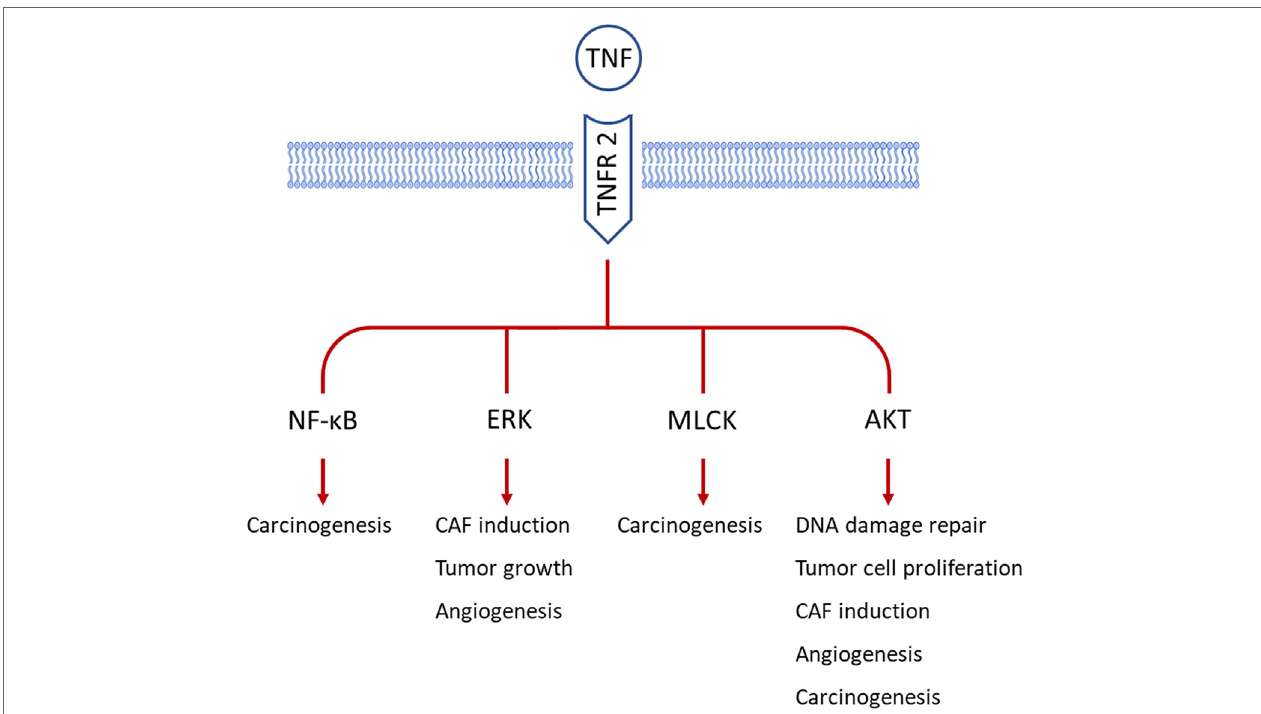
FiGURe 2 | TNF receptor 2 (TNFR2) participates in various processes of tumor development by employing different signal pathways in tumor cells. So far, TNFR2 is reported to be expressed on tumor cells from breast cancer, cervical cancer, colon cancer, and renal cancer. AKT signaling is the major mediator of TNFR2 in carcinogenesis, tumor growth, angiogenesis, and cancer-associated fibroblast (CAF) induction. Besides, myosin light-chain kinase (MLCK) and nuclear factor- κ B (NF- κ B) are involved in TNFR2-related malignant transformation of epithelial cells. Extracellular signal-regulated kinase (ERK) is also important for the above- mentioned functions of